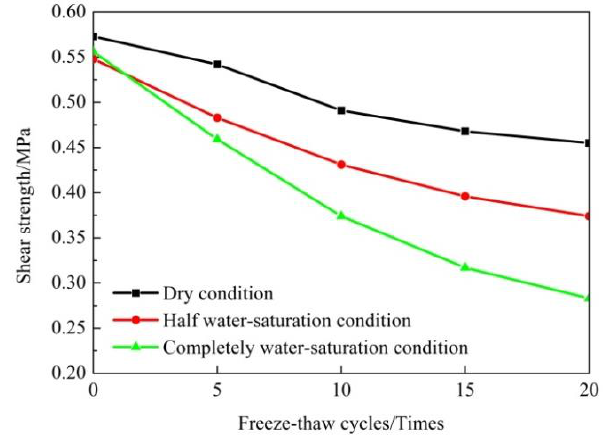
9 of 16 Figure 3. Air voids under freeze – thaw cycles with different water saturation conditions. 3.2. High-Temperature Stability As schematically illustrated in Figure 4, the shear strength of CRME decreased as freeze – thaw cycles increased in different water saturation conditions. The shear strength decreased significantly when the water saturation ratio increased. After 20 freeze – thaw cycles, the shear strength decreased up to 20.6%, 31.8%, and 49.1% in dry condition, half water saturation condition, and complete water saturation condition, respectively. The internal damage of CRME occurred due to temperature stress in the dry condition. The damage of CRME accumulated gradually as freeze – thaw cycles increased in the dry con- dition. The shear strength of CRME decreased in the dry condition. The serious internal damage of CRME occurred due to the temperature stress with water erosion in the half